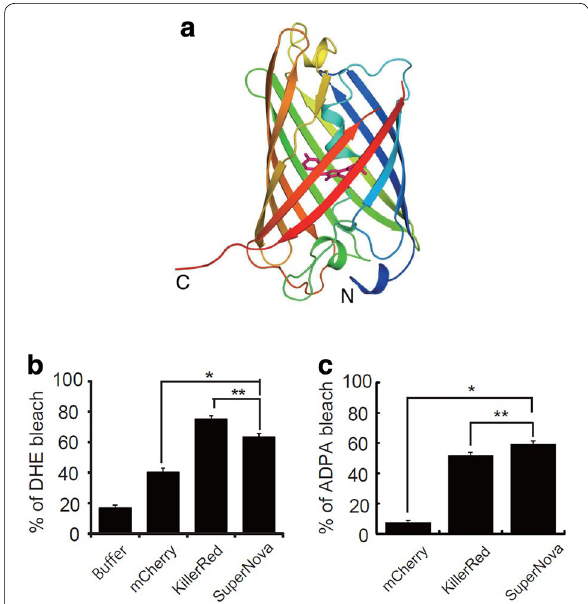
Fig. 7 a 3D crystal structure of SuperNova (Reproduced from [59] with the permission of Springer Nature). SuperNova (monomer) is represented by the rainbow ribbon diagram and the chromophore is represented by the magenta stick model. b , c ROS detection generated from SuperNova (Reproduced from [59] with the permis‑ sion of Springer Nature). b Detection of O 2• ‒ photogeneration of mCherry, KillerRed, and SuperNova by measuring bleaching of DHE fluorescence, including references (buffers). The irradiation condition was 0.73 W cm − 2 for 10 min. c Detection of 1 O 2 photogeneration in mCherry, KillerRed, and SuperNova by measuring bleaching of ADPA fluorescence. The irradiation condition was 1.4 W cm − 2 for 5 min. mCherry (λ ex 587 nm and λ em 610 nm) is a monomeric fluores‑ = = cent protein variant derived from the Discosoma red (DsRed)